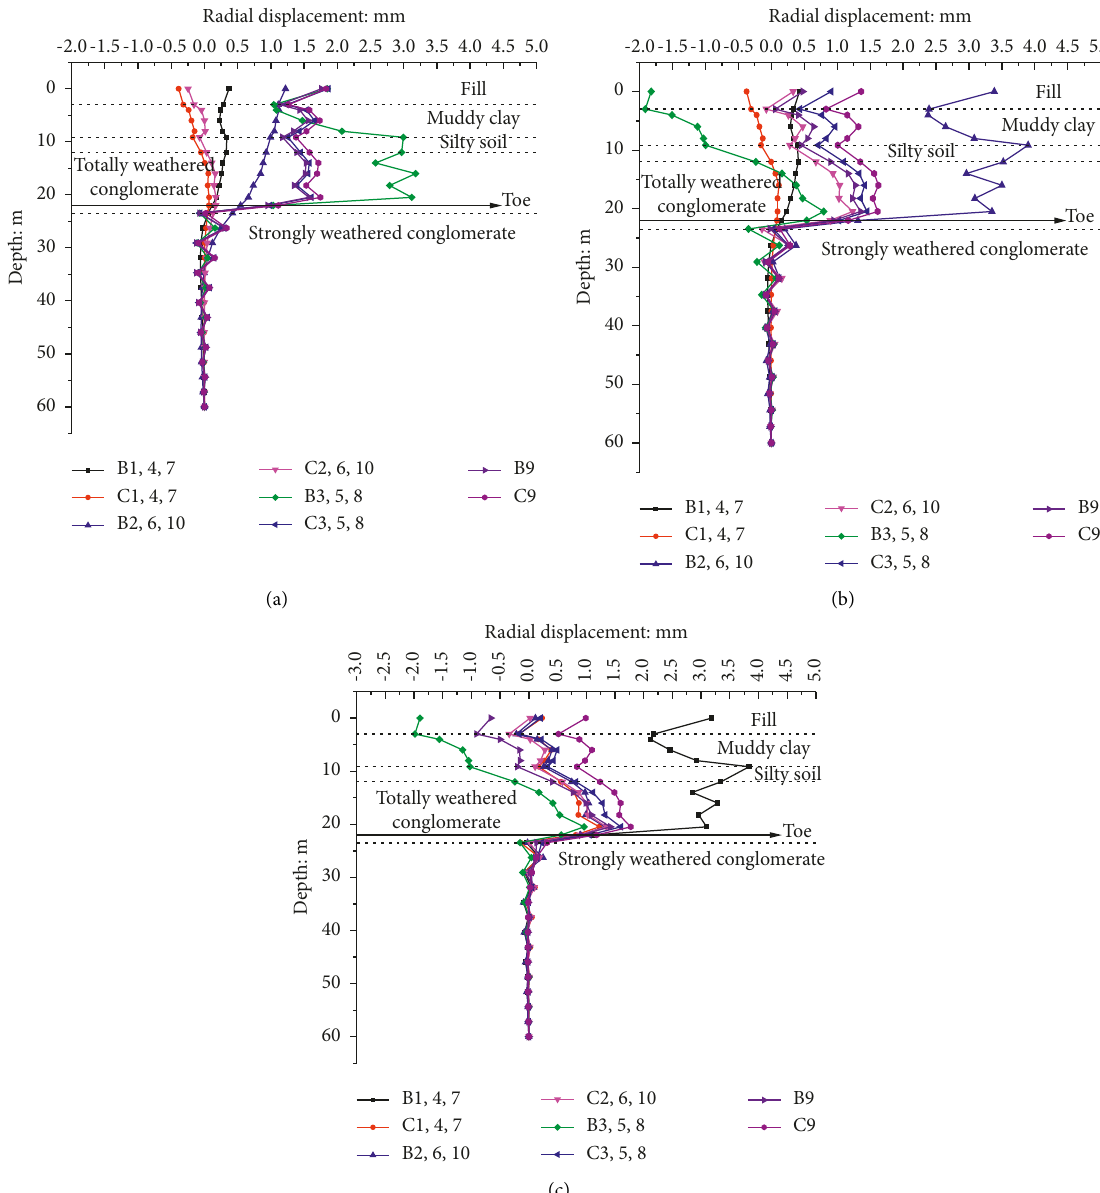
Figure 13: Change in radial displacement distribution with depth during construction. (a) Behind Gutter 5. (b) Behind Gutter 6. (c) Behind Gutter